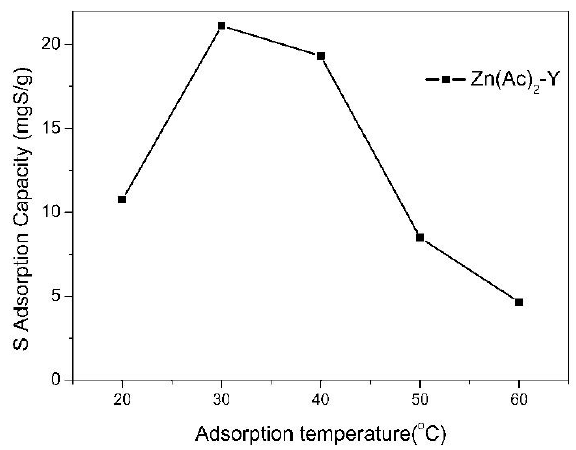
Figure 6. Effect of adsorption temperature on sulfur adsorption capacity (initial sulfur concentration: 1000 ppmw, t = 2 h, adsorbent dosage = 20 g/L; ion-exchange time: 10 h, ion-exchange temperature: 60 °C).